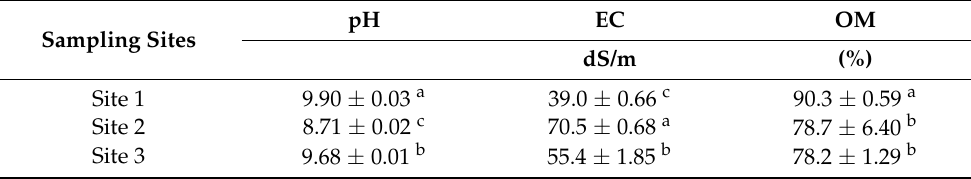
Table 2. Chemical properties of manure-based compost in each sampling site.